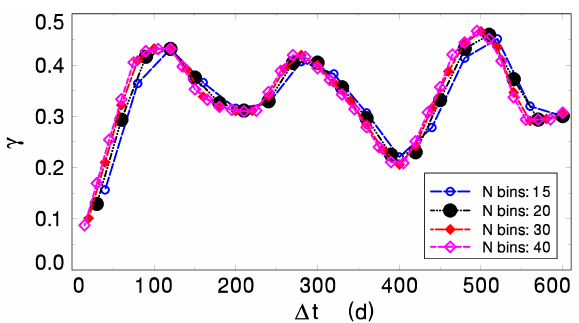
Figure 5: Variogram for the observed data of the su- persoft X-ray source V Sge (from Fig. 4). N bins refers to the number of bins used for constructing the vari- ogram.